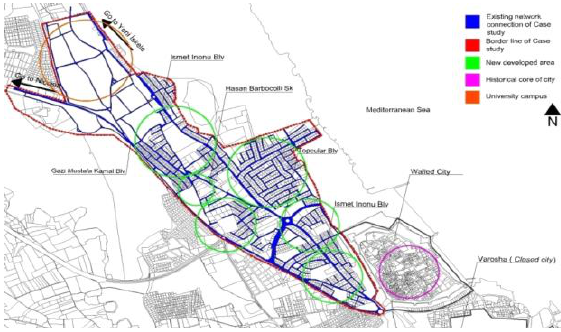
Figure 1. Selected area in Famagusta as a case study